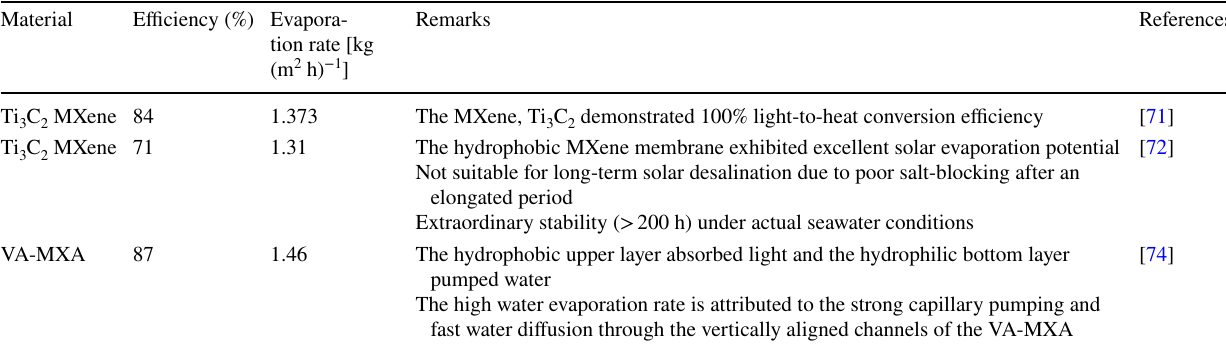
Table 3 Solar evaporation performance of MXene membranes